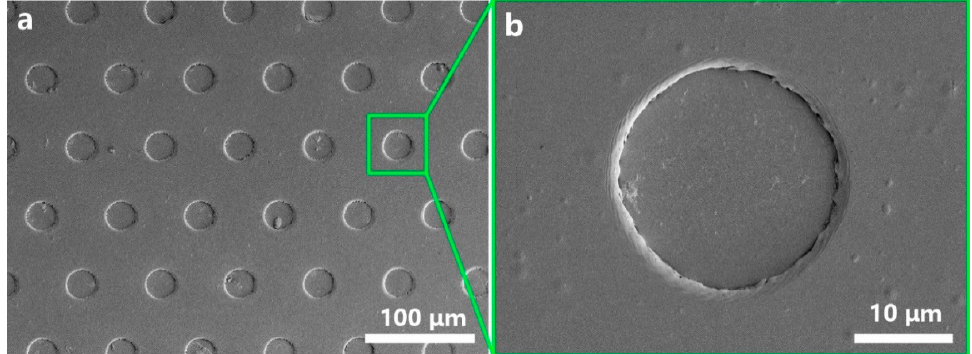
Figure 10. ( a ) Low- and ( b ) high-magnification SEM images of the ultra-thin PI film contact spacer.